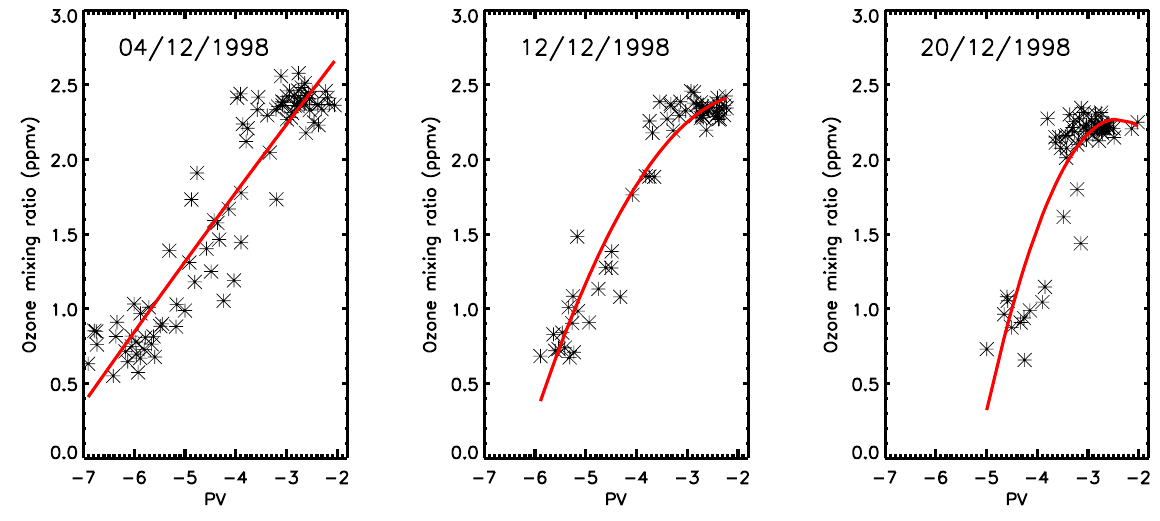
Fig. 7. Ozone mixing ratio (in ppmv) and PV (in 10 − 5 · Kkg − 1 m 2 s − 1 ) for the Southern Hemisphere POAMIII measurements on the 500K isentropic surface, for three days, 4, 12 and 20 December 1998. The red line represents the quadratic